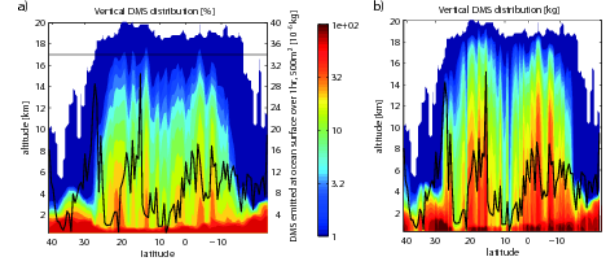
Fig. 4. Comparison between HIPPO2 atmospheric DMS observa- tions and FLEXPART DMS simulations (1 / 2-day atmospheric life- time). Measurement locations for HIPPO2 (left panel) and compar- ison between HIPPO2 and FLEXPART coincidences (right panel) are shown. Note: DMS (ppt) of right panel is logarithmic.